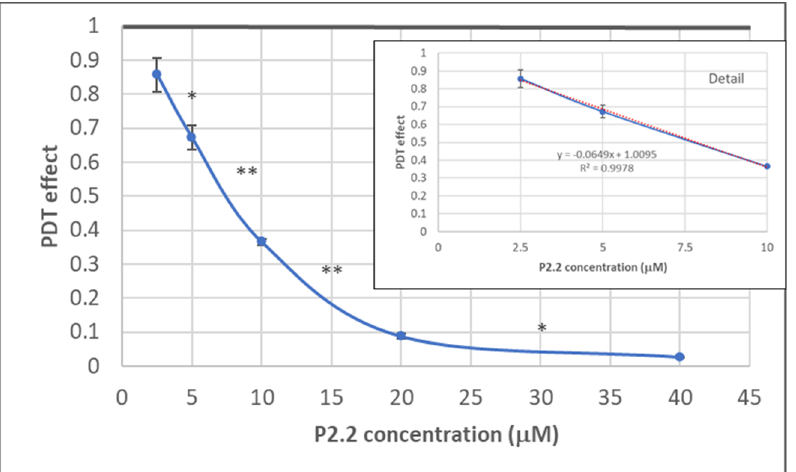
Figure 3. The dependence on P2.2 concentration of MTS reduction by HT29 tumor cells at 24 h post-PDT. Results are presented as PDT effect (mean ± SEM) in triplicate samples. PDT effect was calculated as OD in PDT-treated samples divided by the mean value of OD in control samples. Comparison between samples was performed using Student’s t -test: paired two sample for means: * p < 0.05, ** p < 0.01.